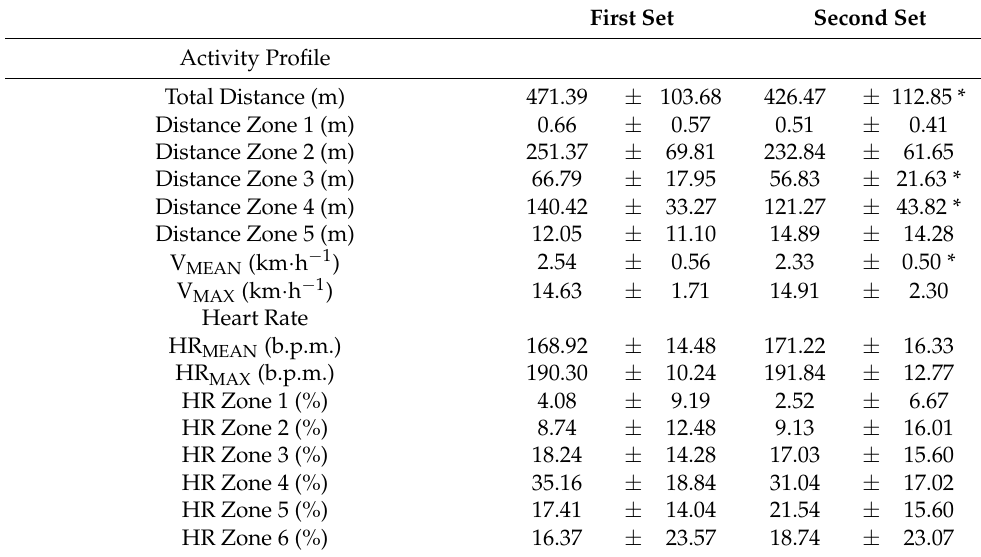
Table 1. Activity profile and heart rate values of women beach handball players during a tournament.